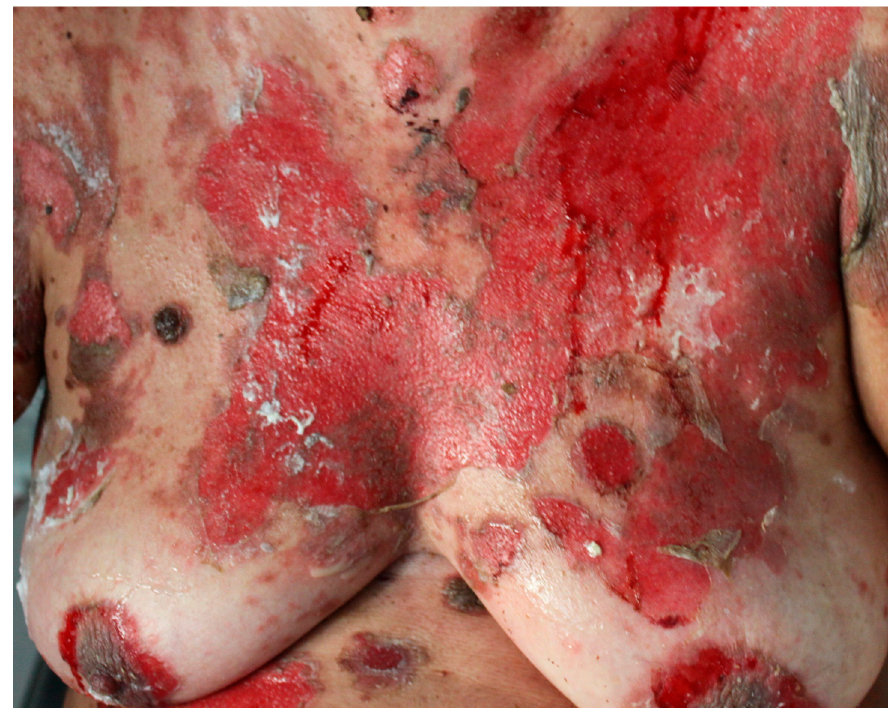
Figure 3. PNP skin lesions. Diffuse erythema, exfoliative erythroderma, erosions, or ulcerations on the trunk and abdomen.